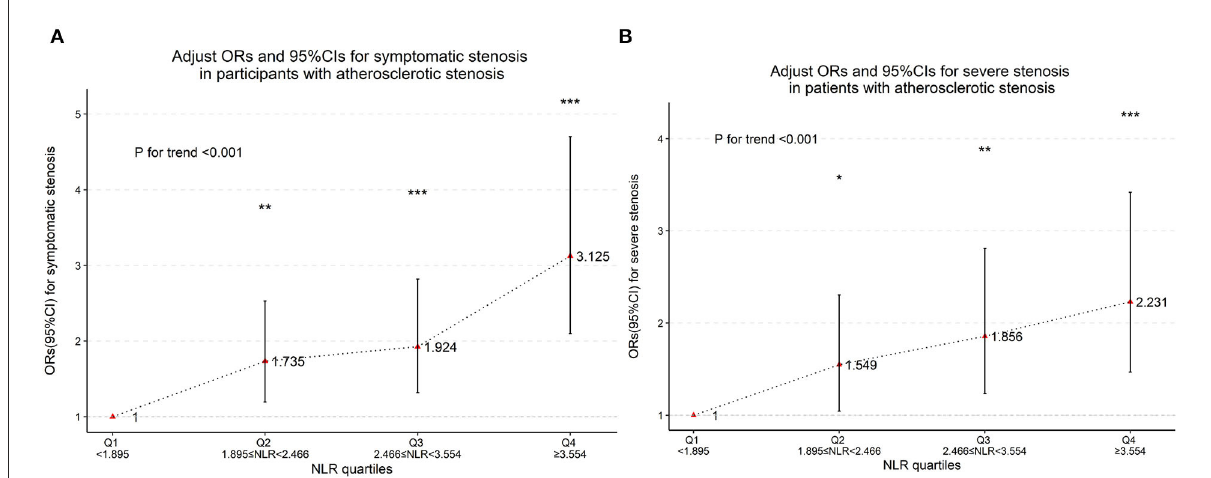
FIGURE4 Multinomial-adjusted odds ratio (Ors) and 95% confidence interval (95%Cis) for symptomatic stenosis (A) and severe stenosis (B) according to neutrophil-to-lymphocyte ratio (NLR) quartiles. Ors were adjusted for “sex,” “age,” “hypertension,” “diabetes,” “stroke,” and “smoking.” NLR was significantly associated with severe stenosis and symptomatic stenosis in the second, third and fourth quartiles (the first NLR quartile as reference). * p < 0.05, ** p < 0.01, *** p < 0.001, p for trend < 0.001.